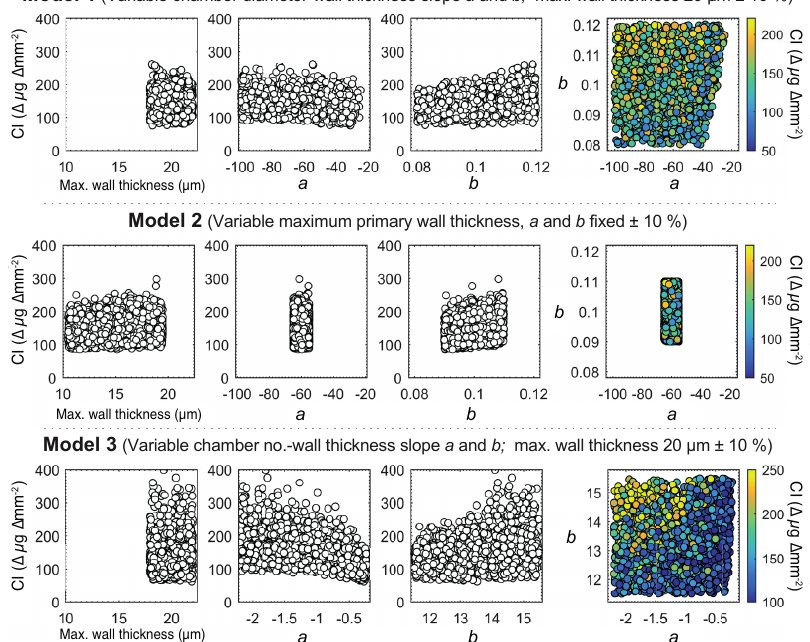
Figure A2. Modelled dependence of CI on morphological parameters within the three model groups for foraminifera of ∼ 0.1mm 2 . No parameter exerts a systematic control on CI in foraminifera of this size with the exception of the coefficients a and b that parameterise the relationship between body size and primary wall thickness (see Eq. A2). In model 1 (top row), these coefficients are varied, but the maximum primary wall thickness (i.e. before secondary thickening) is kept at 20 ± 2µm. In model 2, conversely, a and b are constrained, with maximum chamber thickness allowed to vary. In model 3, wall thickness is scaled with at chamber addition step, rather than chamber size. Regardless of base model, varying a and b will drive CI changes (bottom and top row, central pairs). Varying maximum wall thickness does not drive such a relationship (middle row left). When changed together, the a and b explain ∼ 50% of the variance in CI, as illustrated by the coloured plots (models 1 and 3, top- and bottom-right